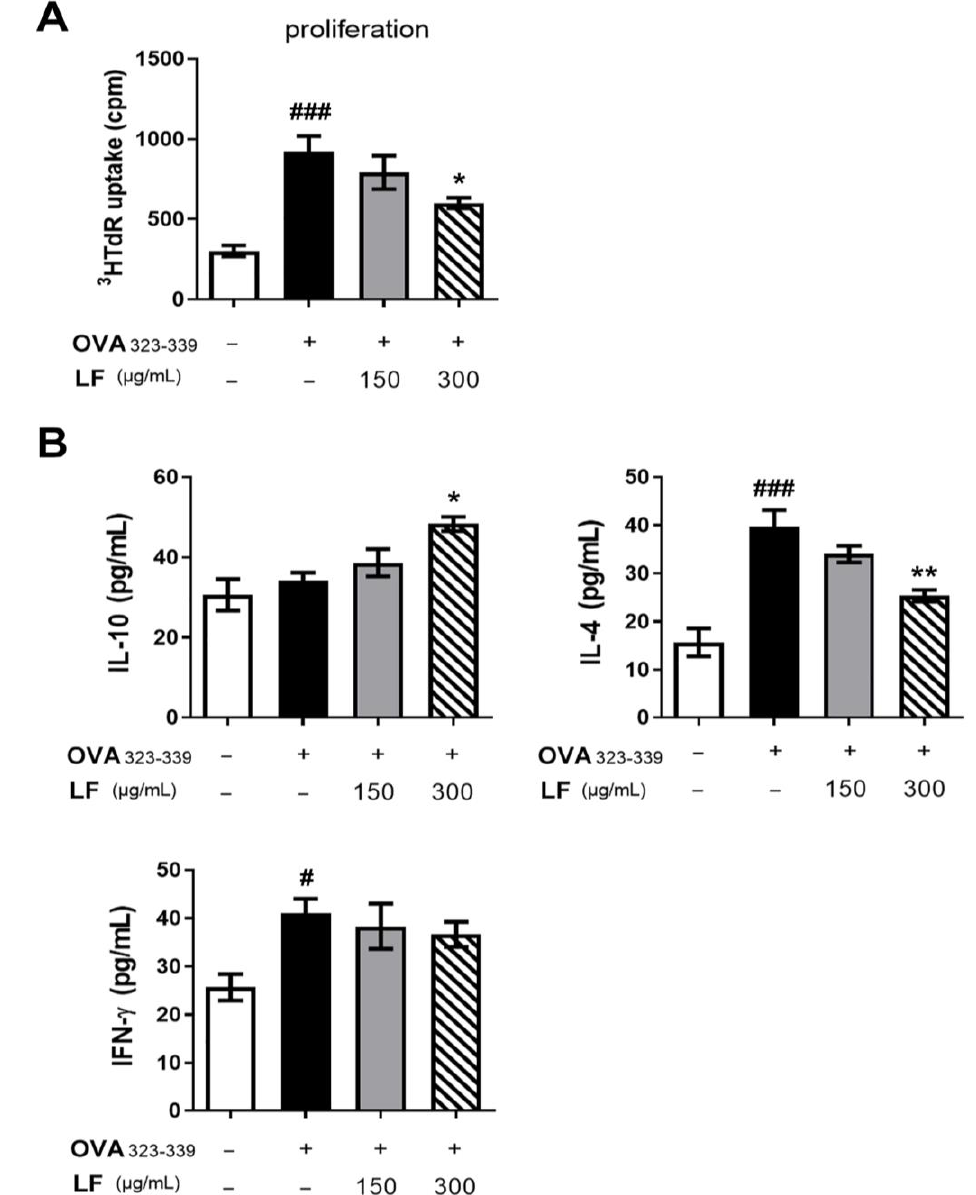
Figure 6. Lactoferrin inhibits OVA-specific T-cell activation induced by OVA 323–339 (OVAP2) peptide-loaded DCs in vitro. BMDCs from C57BL/6 mice were incubated with or without lactoferrin (150 or 300 μg/mL) and then pulsed with OVA323–339 (OVAP2) peptide for 24 h. After incubation, the isolated DCs and OT-II CD4 + T cells were cocultured with DCs:T at a ratio of 1:10 for 72 h. ( A ) The proliferation rate of cocultured cells was evaluated by [ 3 H] thymidine uptake. ( B ) The levels of IL-10, IL-4, and IFN- γ production in cocultured cells were detected by ELISAs. The data are expressed as the mean ± S.E.M. values ( n = 5). # p < 0.05, ### p < 0.001 vs. the NC group; * p < 0.05, ** p < 0.01